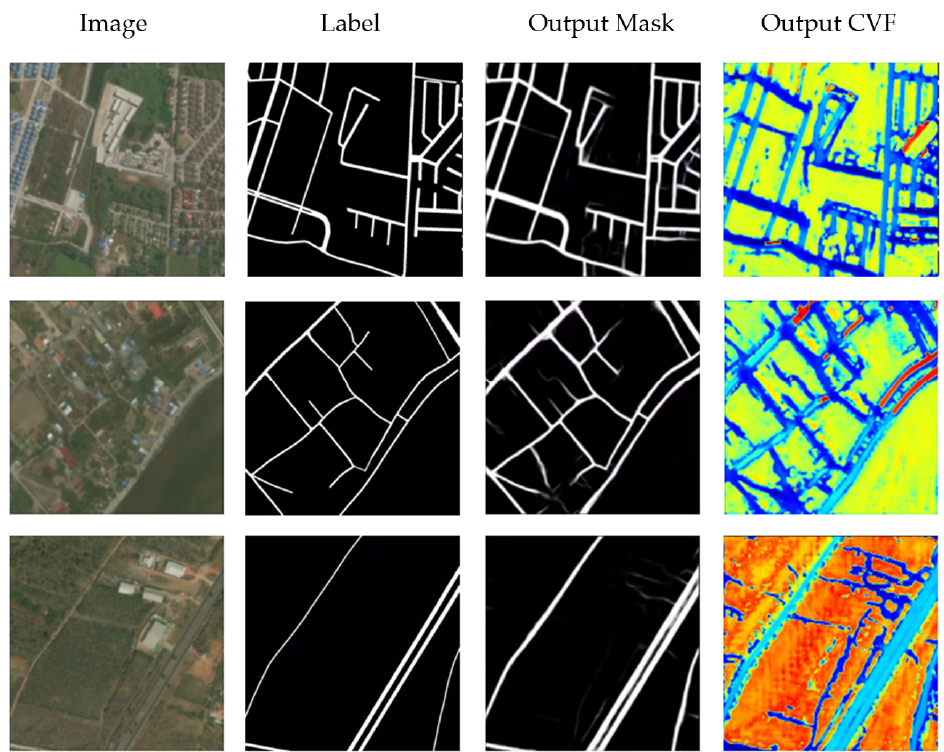
Table 1. The performance evaluation of road extraction using mask learning only.